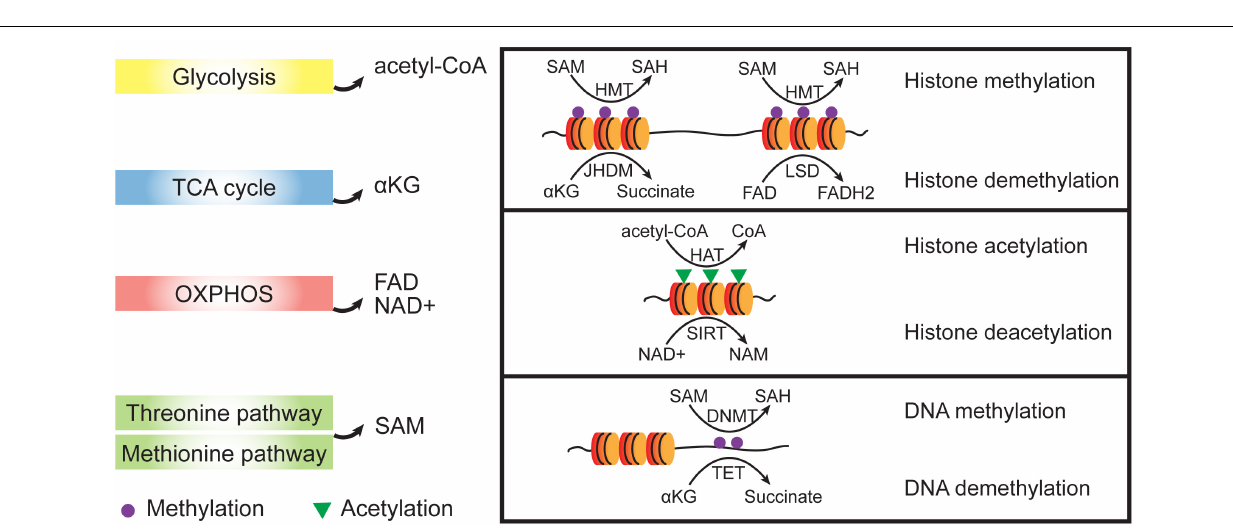
FIGURE 3 | Crosstalk between metabolic and epigenetic regulation. Metabolites from different metabolic pathways participate epigenetic regulation as cofactors. Dioxygenases such as HMTs and DNMTs use SAM as methyl group donor and the reverse demethylation reactions use α KG or FAD to receive the methyl groups. Acetylation of histones is achieved by HATs which transfer acetyl groups from acetyl-CoA. To remove acetyl group from histone proteins, NAD+ is used as a cofactor to support the SIRT activities which belongs to histone deacetylases (HDACs). SAM, S-adenosyl methionine; SAH, S-adenosyl homocysteine; NAD+,